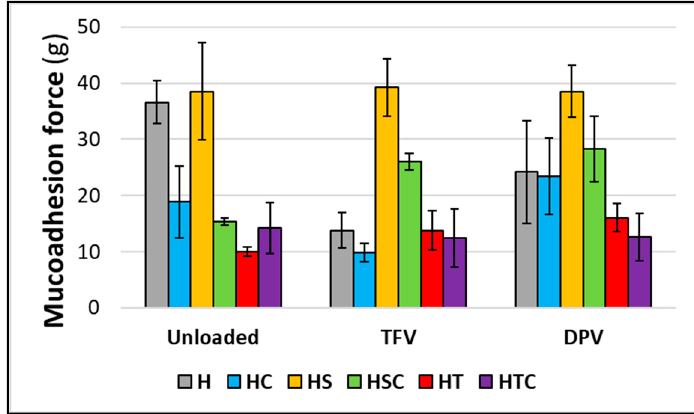
Figure 14. Mucoadhesion force required to detach the vaginal discs. Mean ± SD are presented ( n = 3). Table 4. p -Values obtained in the comparison of the group of batches by paired t-test. Significant di ff erences are in